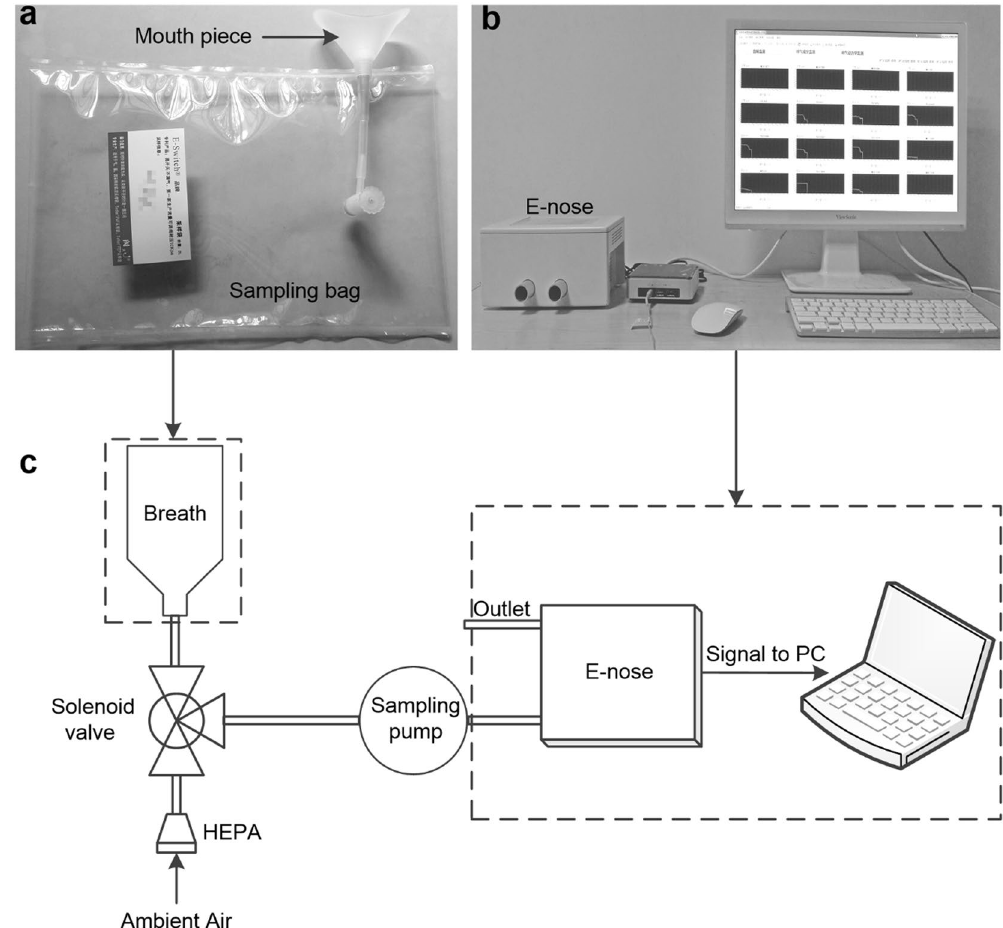
Figure 2. Overview of the breath sampling and analysis system. ( a ) Tedlar ® bag for breath sampling. ( b ) Photograph of the E-nose system and software interface. ( c ) Block diagram of the